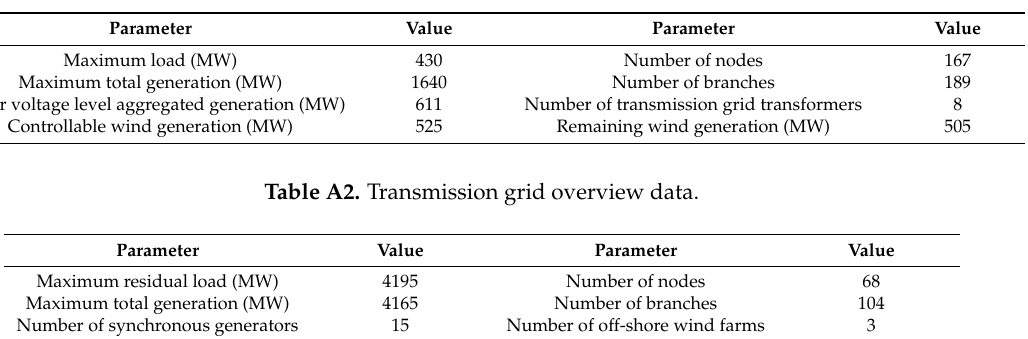
Table A1. Distribution grid overview data.